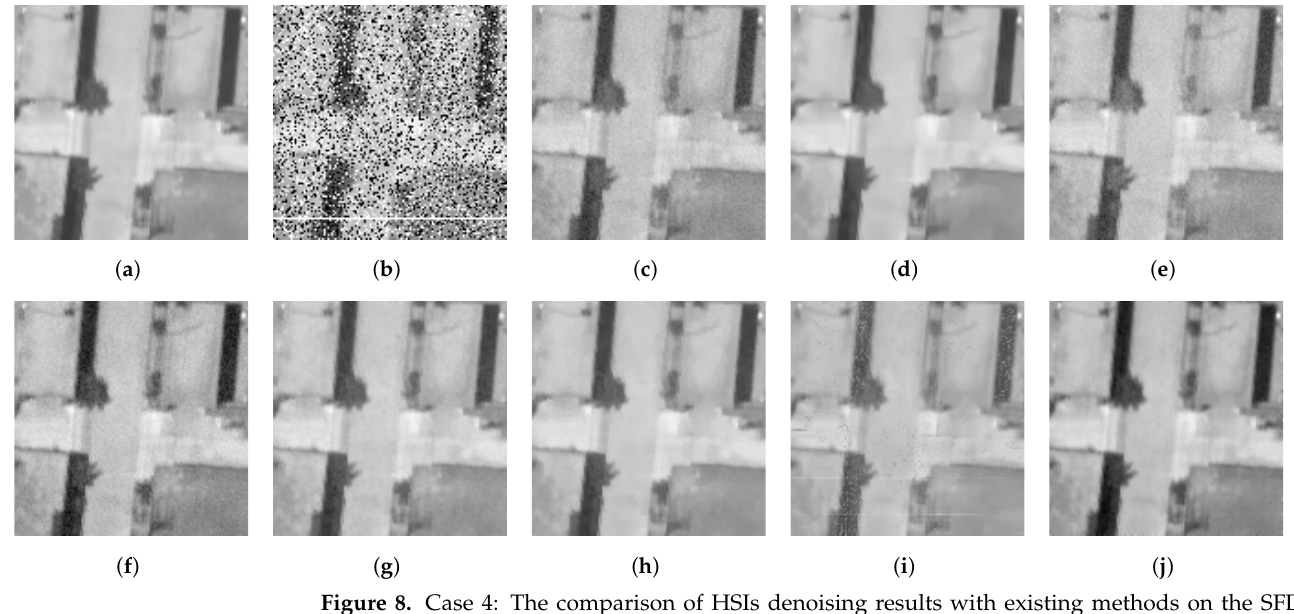
Figure 8. Case 4: The comparison of HSIs denoising results with existing methods on the SFD dataset: ( a ) ground truth of band 21; ( b ) noisy image; ( c ) NNM; ( d ) BM4D; ( e ) WNNM; ( f ) WSNM; ( g ) LRTDTV; ( h ) 3DTV; ( i ) FastHyDe; and ( j ) the proposed method.